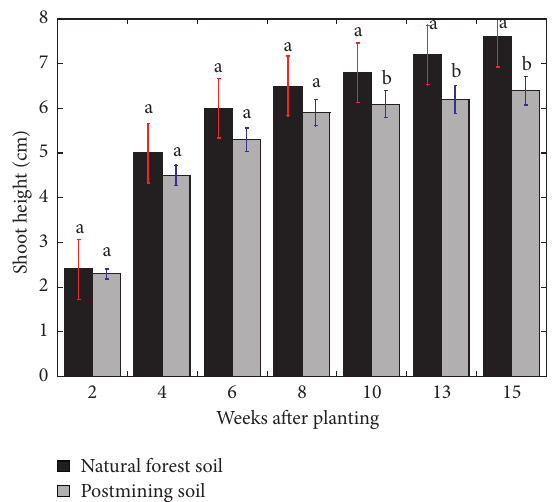
Figure 2: Mean shoot height of Falcataria moluccana grown in soil from post-nickel mining land and natural forest for 15 weeks under greenhouse condition. Different letters indicate significant differ- ences ( P � 0 . 05). Error bars indicate standard error ( n �